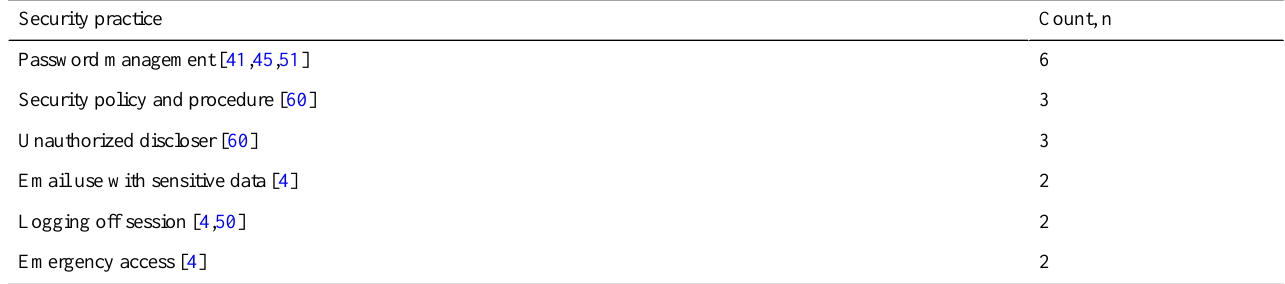
Table 3. Security